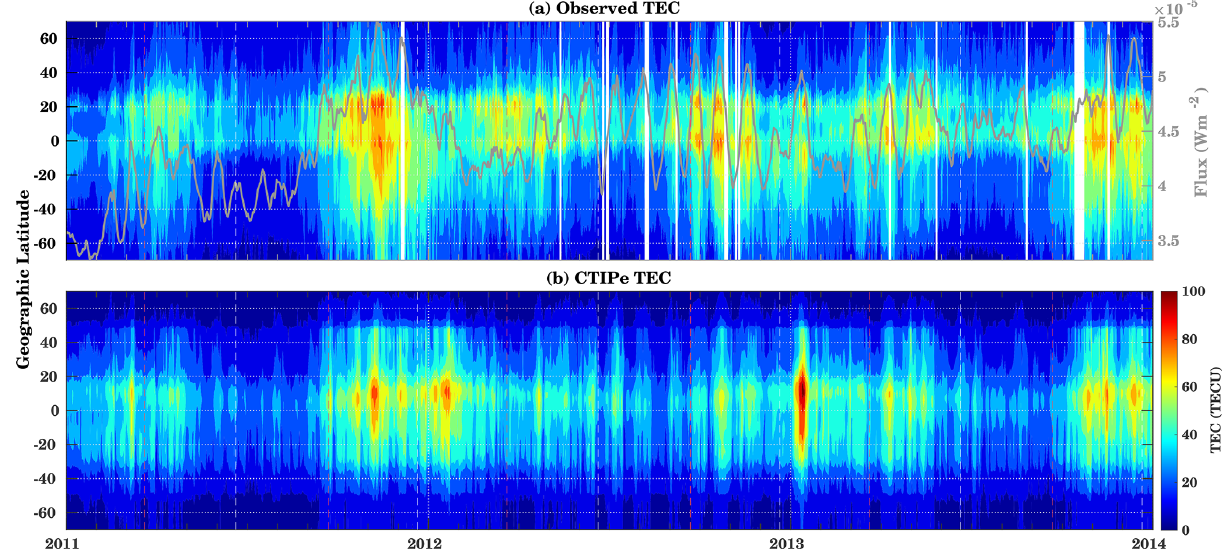
Figure 3. Latitudinal variation of (a) observed TEC and (b) model-simulated TEC around noon (11:00–13:00LT) at 15 ◦ E longitude. The gray curve in panel (a) represents the SDO EVE-integrated flux